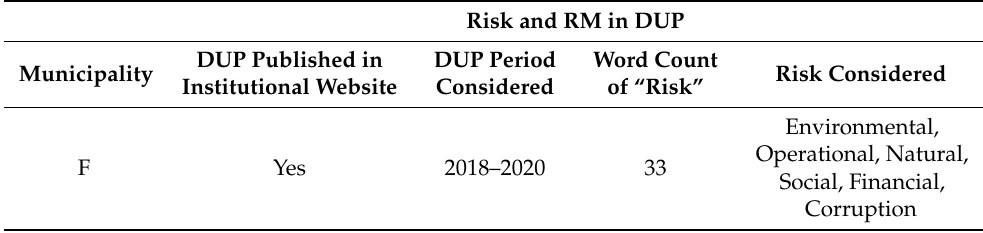
Table 7. Analysis of DUP in Municipality F.